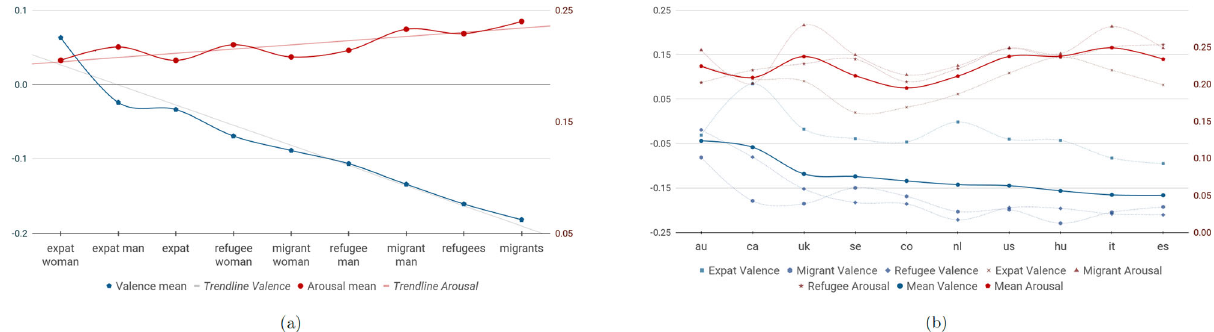
Fig. 2 Average estimated emotional valence and arousal. Results are presented per a group and b location. The right axis corresponds to valence and the left axis to arousal.